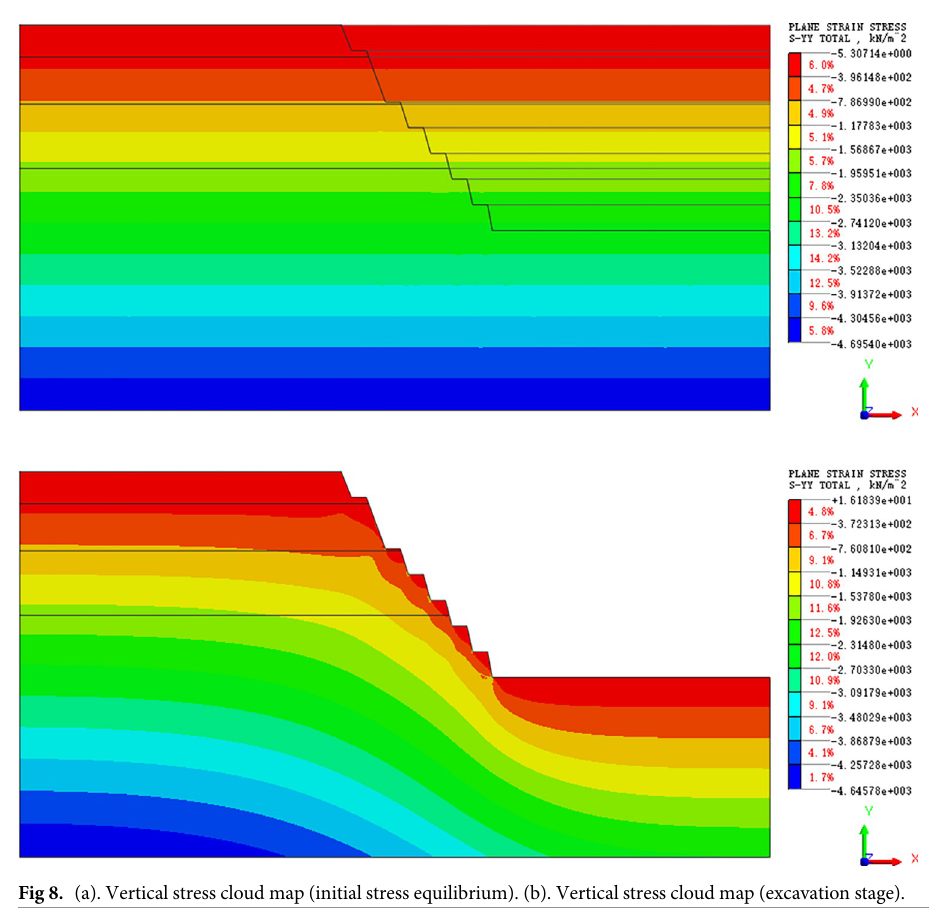
Fig 8. (a). Vertical stress cloud map (initial stress equilibrium). (b). Vertical stress cloud map (excavation stage).